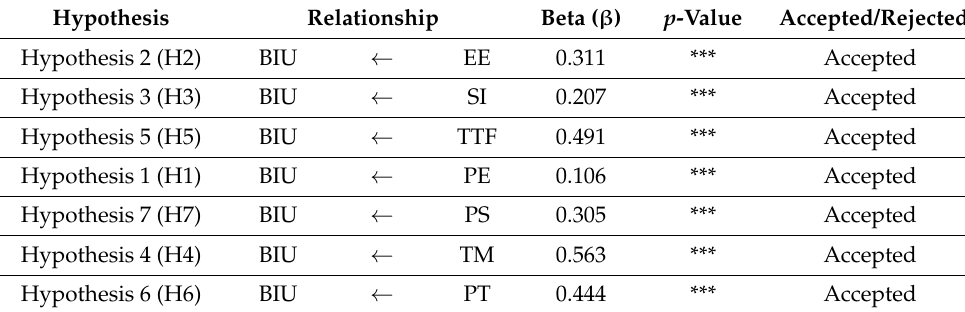
Figure 2. Evaluation of the research model. Table 4. Evaluation of study hypotheses.